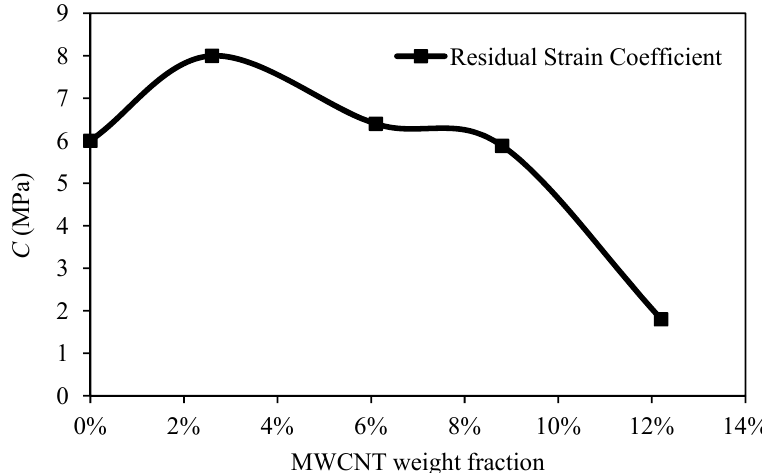
Figure 5. Residual strain material parameter values, C , plotted as a function of the weight fraction of